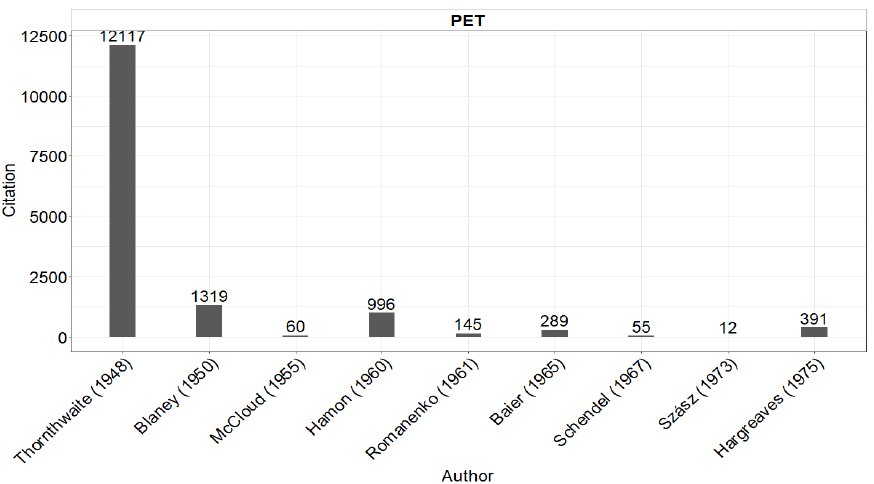
Figure 2. Citations of PET temperature-based equations.